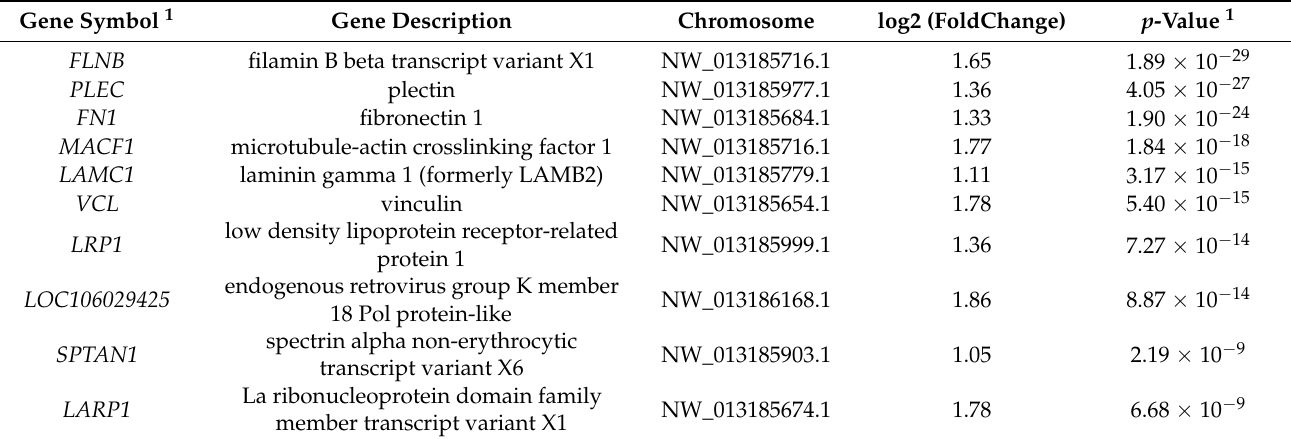
Table 6. Top 10 upregulated DEGs.